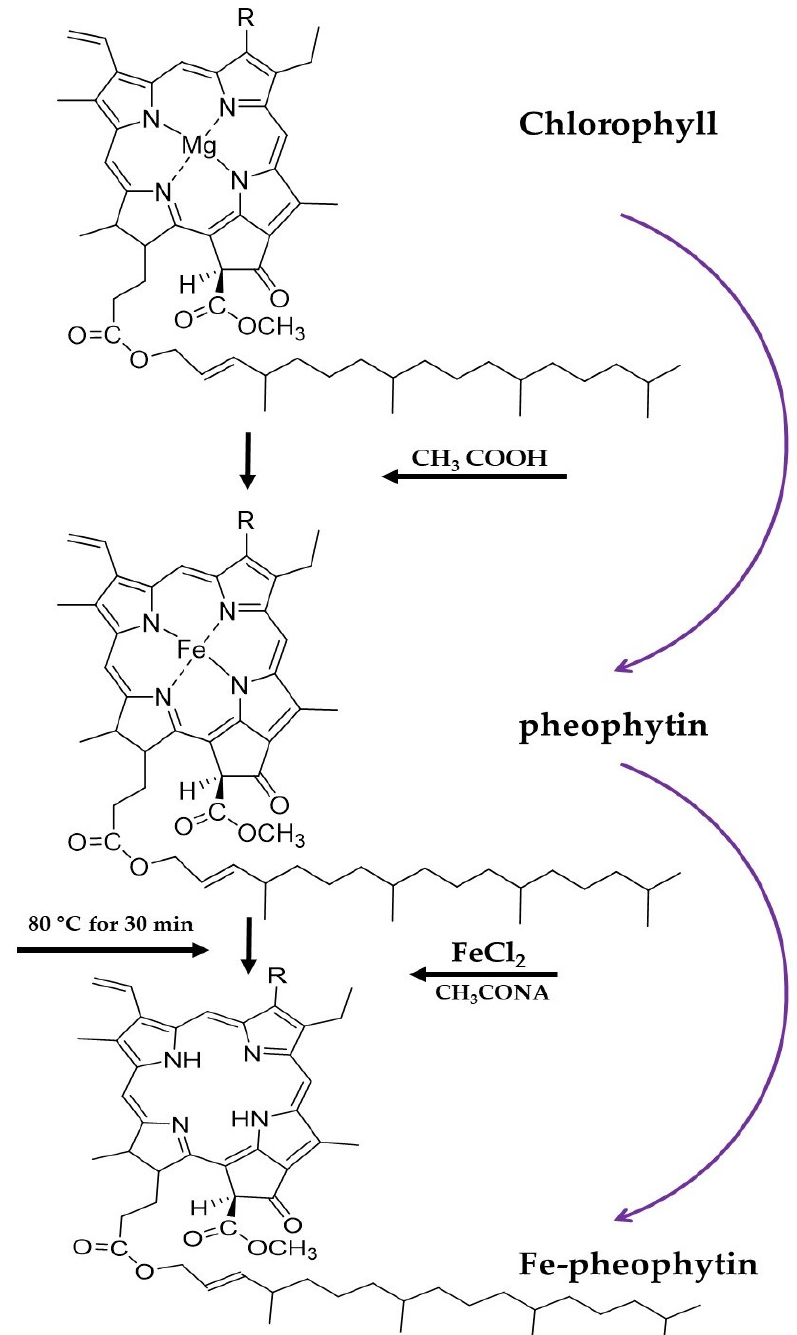
Figure 3. Reaction scheme for the synthesis of pheophytin and Fe-pheophytin. Derivatives of natural chlorophyll are present in crude spinach extract (PubChem).